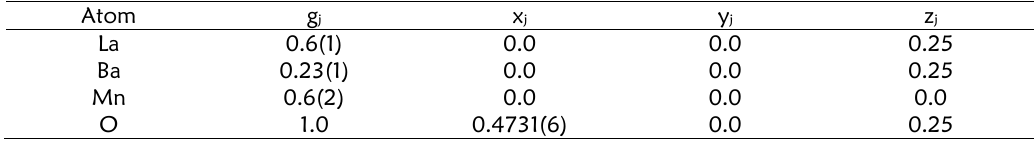
Table 12. The coordinates of atomic fractions (x j , y j , z j ), and atomic occupancy factor (g j ) of S3 sample based on neutron diffraction data.